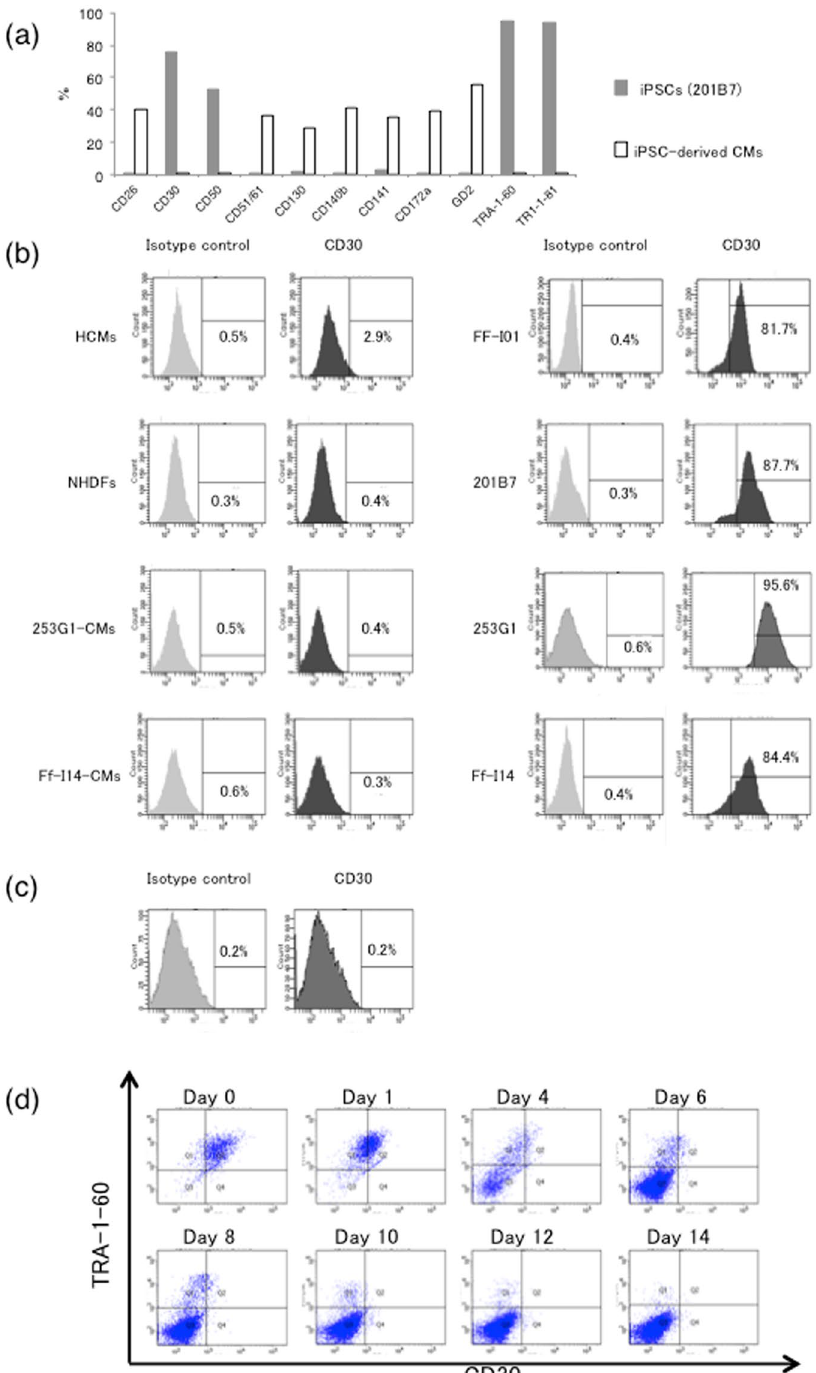
Figure 1. Expression of CD30 on hiPSCs ( a ) Expression of surface markers was compared between hiPSCs and hiPSC derived-CMs. The data are representative of at least three independent experiments. ( b ) Expression of CD30 on several cell surfaces. The number in the histograms indicates the percentage of CD30-positive cells. The data are representative of at least three independent experiments. ( c ) Expression of CD30 on hiPSC- derived CMs. The number in the histograms indicates the percentage of CD30-positive cells. The data are representative of at least three independent experiments. ( d ) Down-regulation of CD30 expression during hiPSC differentiation into CMs. The data are representative of at least three independent